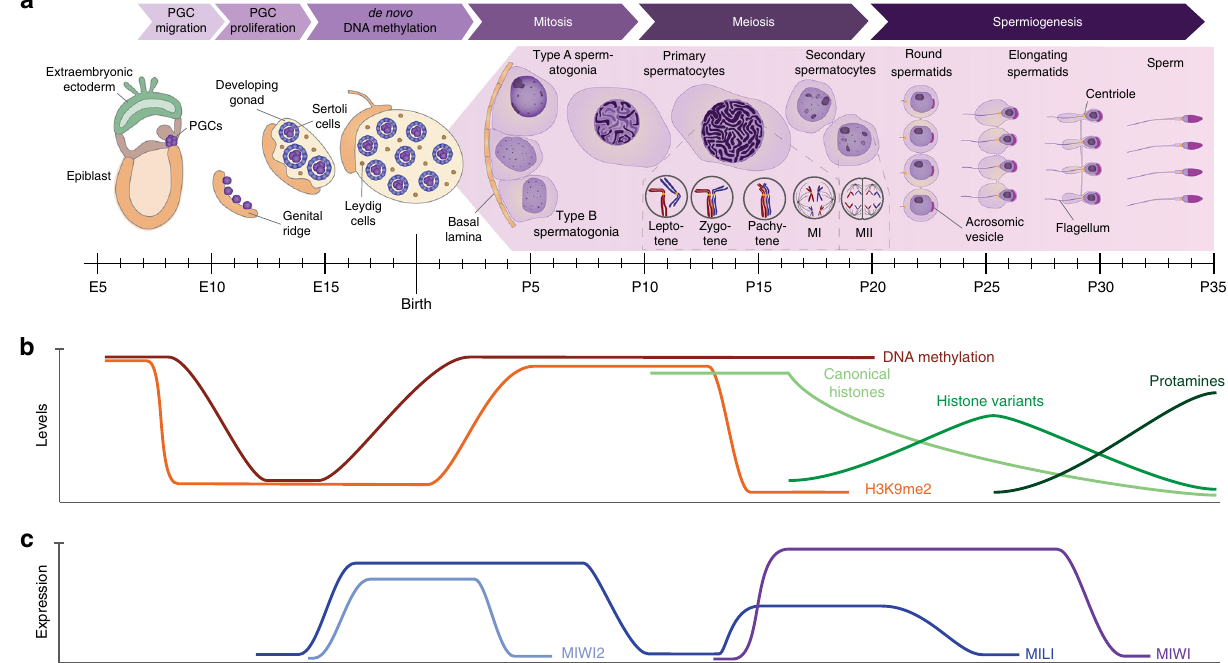
Fig. 1 Male germ cell nomenclature and developmental dynamics of mouse spermatogenesis. a Gametogenesis starts during embryonic development when primordial germ cells (PGCs) are de fi ned and migrate to the genital ridge to form the gonads. Spermatogenesis initiates shortly after birth in synchronized waves. At 10 days post birth (P10), spermatogonial stem cells differentiate into primary spermatocytes that are committed to undergo meiosis. Two consecutive cell divisions (meiosis I and II (MI and MII)) without an intermediate S-phase result in the production of haploid gametes that are called round spermatids. These cells can be found as early as P20 and then undergo spermiogenesis during which the cells elongate and develop sperm-speci fi c structures such as the acrosome and the fl agellum to form mature sperm cells. b The process of gametogenesis is associated with extensive epigenetic reprogramming accompanied by drastic changes in DNA methylation and histone modi fi cations such as H3K9me2. During later stages of spermatogenesis, the mouse genome show very speci fi c expression pro fi les throughout spermatogenesis and re fl ect functionally distinct aspects of the piRNA pathway